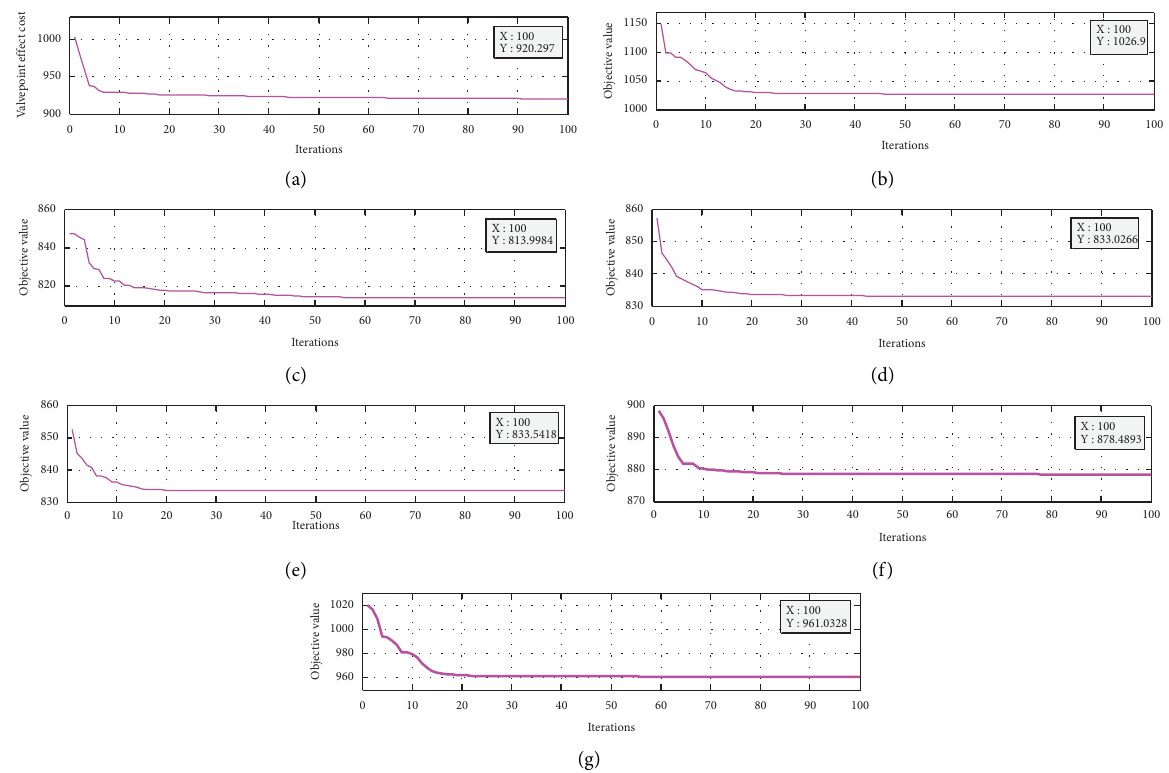
Figure 7: Convergence characteristic curves for multiobjective OPF (case 7 through case 13) of the IEEE 30-bus system: (a) Case 7; (b) Case 8; (c) Case 9; (d) Case 10; (e) Case 11; (f) Case 12; (g) Case 13.